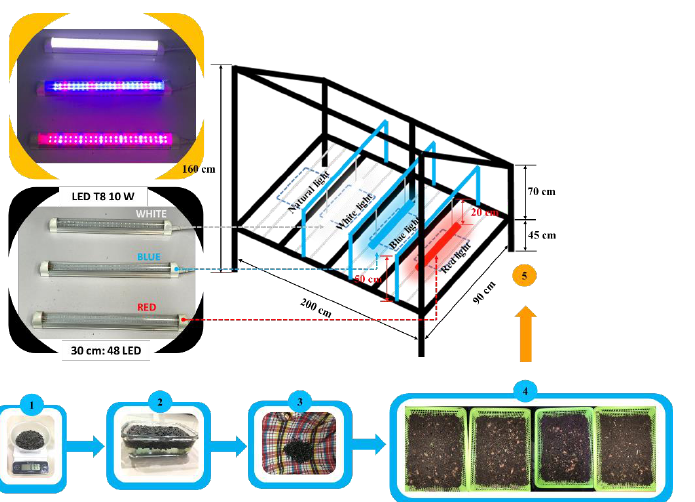
Figure 1. Process of seedling preparation: ( 1 ) selecting sunflower seeds; ( 2 ) soaking sunflower seeds in water; ( 3 ) wrapping the seeds in a towel; ( 4 ) planting the seeds in the nursery tray; ( 5 ) installing a nursery tray in the plant nursery.